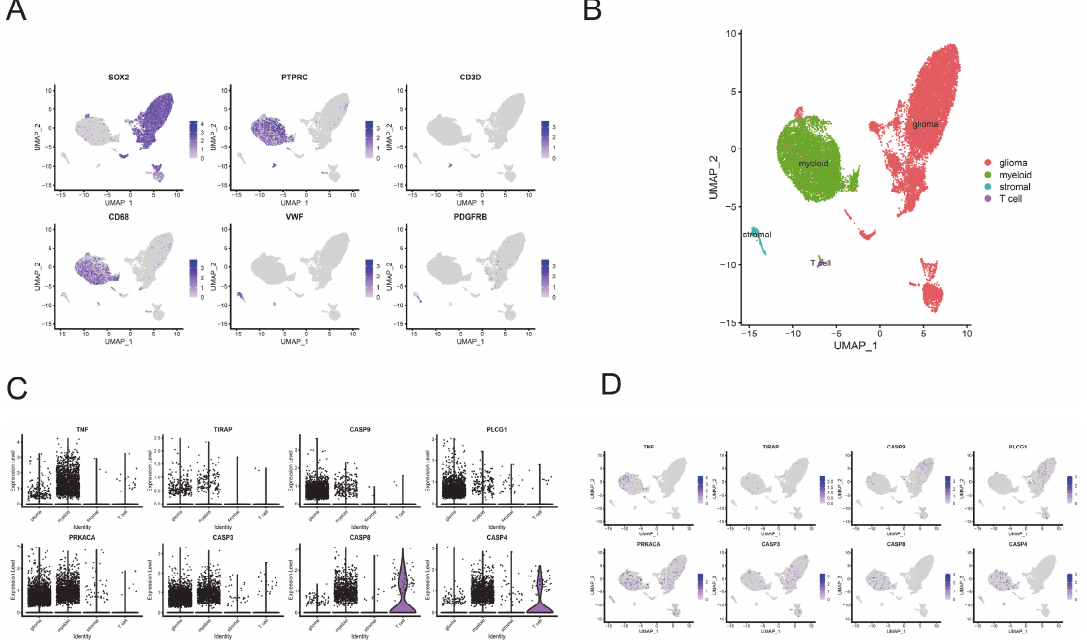
Figure 7. Single-cell analysis of PRGs (GSE182109). ( A ) UMAP plots for marker genes. ( B ) UMAP plots for all cells. ( C ) Violin plots of the expression of 8 target genes in 4 cell subtypes. ( D ) UMAP plots of the eight target genes’